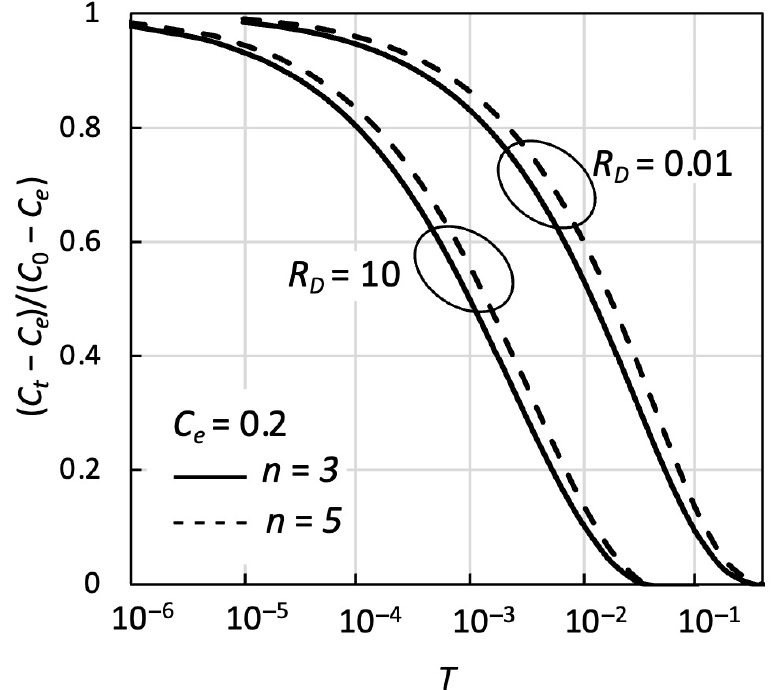
Figure 3. The concentration decay curves simulated by the model under study.